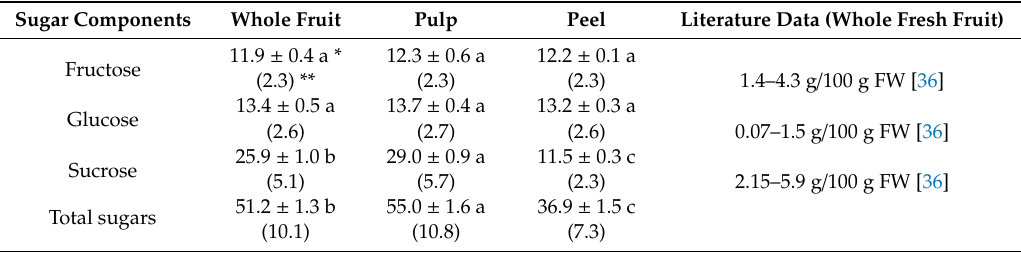
Table 4. Sugar content in feijoa fruit (g / 100